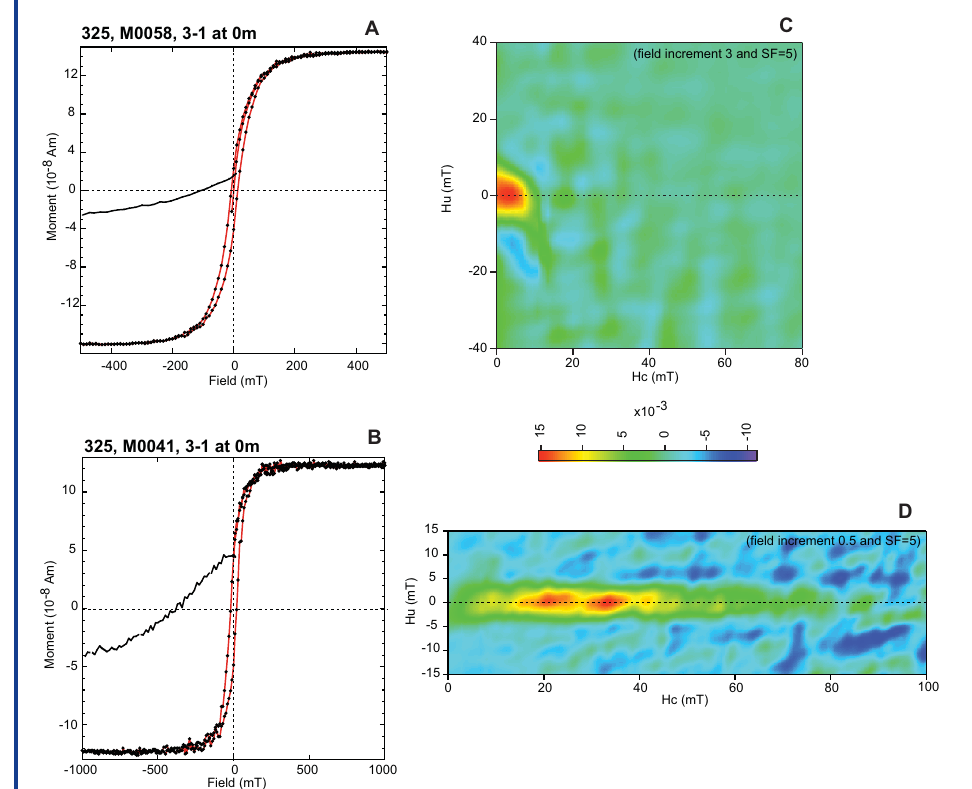
Figure 10. Hysteresis loops, back-field curve ([A], [B]) and first-order reversal curve (FORC) ([C], [D]) of samples from Hole M0058A and M0041A performed with software package FORCinel (Harrison and Feinberg, 2008). The sample from Hole M0058A (field increment 3 mT and SF=5) shows rock magnetic properties mainly of a low coercivity material terrigenous magnetite. The sample from M0041A shows the presence of non-interactive SD magnetite that may represent the presence of